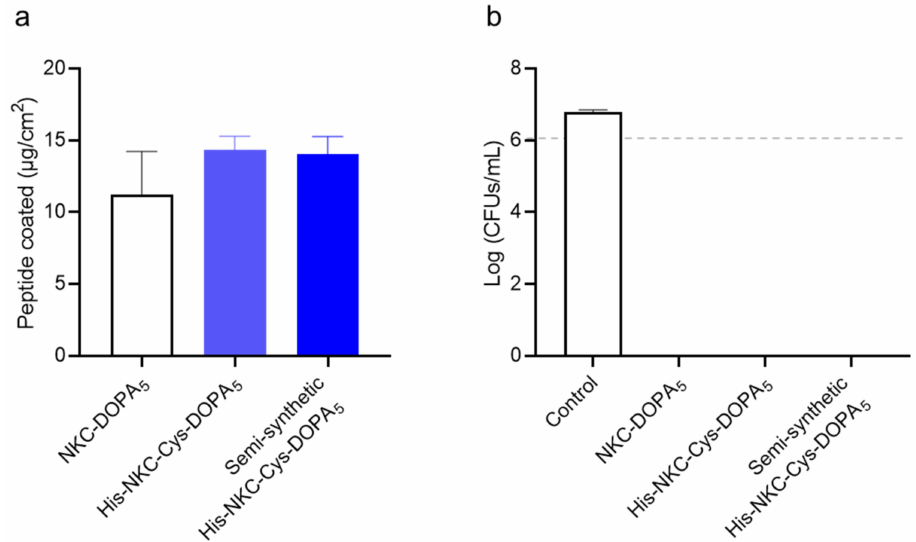
Figure 5. Comparison of the activity of chemically synthesized His-NKC-Cys-DOPA 5 and semi- synthetic His-NKC-Cys-DOPA 5 . ( a ) Surface-binding activity of peptides. ( b ) Surface antimicrobial activity against E. coli . The dashed line indicates the number of cells inoculated. Uncoated wells served as controls. CFUs, colony-forming